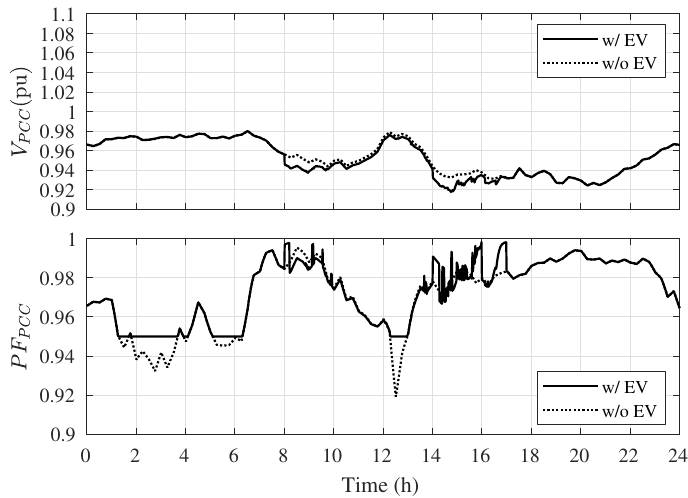
Figure 12. Power factor and voltage at the PCC of the proposed microgrid for scenario 2. The only difference verified is the slight deviations in the middle of the day, due to the EV activity around 2 p.m., corresponding to the connection of EV 2 . Equivalent to the previous scenario, the voltage at the PCC does not suffer heavy influences from the vehicles and remains in a suitable